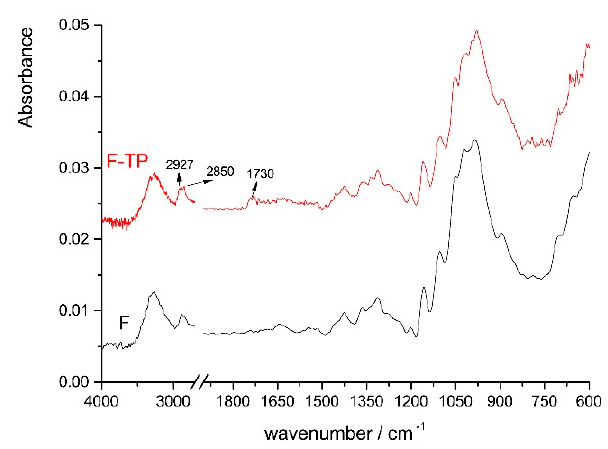
Figure 8. FTIR spectra of filter paper (F) and thermochromic print on filter paper (F-TP).